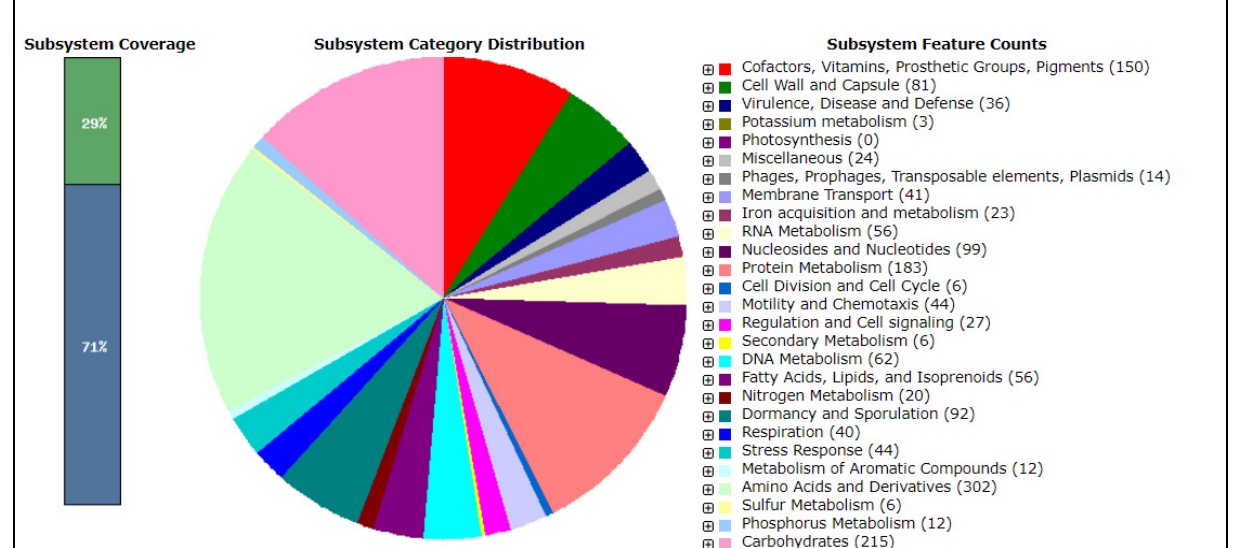
Figure 5. Subsystem Information for B. velezensis KS04AU. In subsystem coverage, 29% is indicated in subsystem coverage with a total of 1180 genes (1125 non-hypotheticals and 55 hypotheticals) and 71% is not indicated in subsystem coverage with a total of 2961 genes (1508 non-hypotheticals and 1453 hypotheticals).